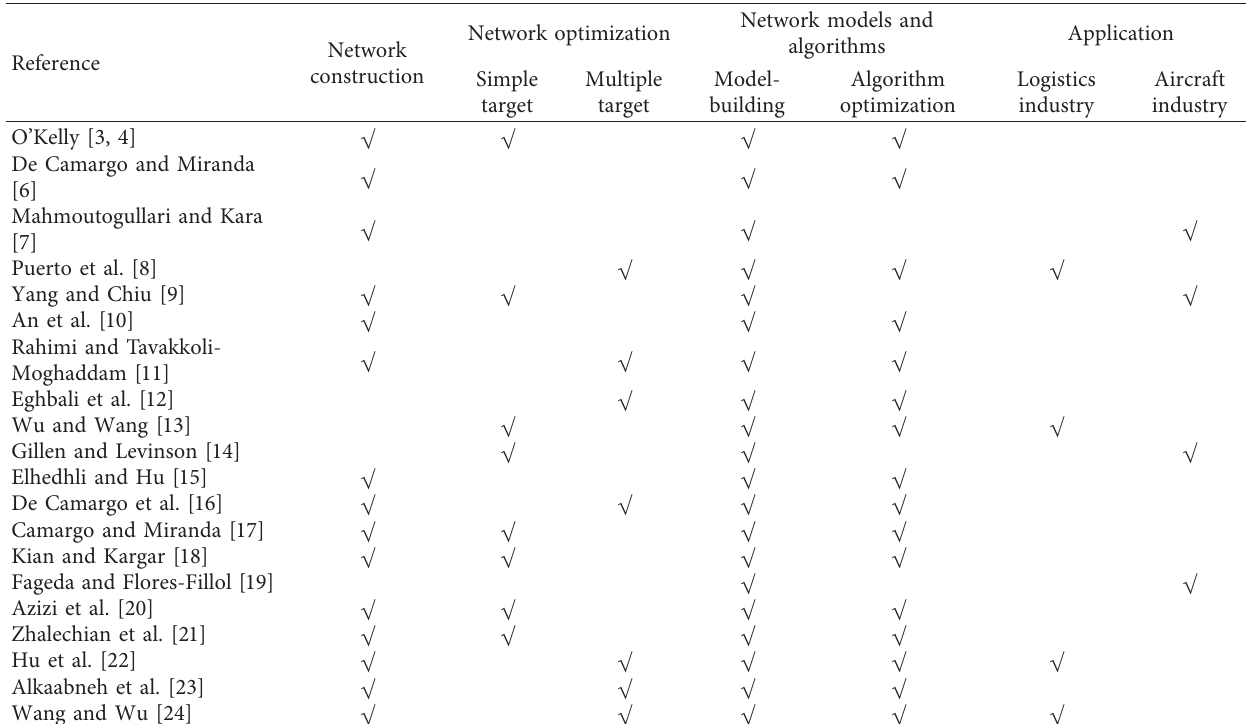
Table 1: Research